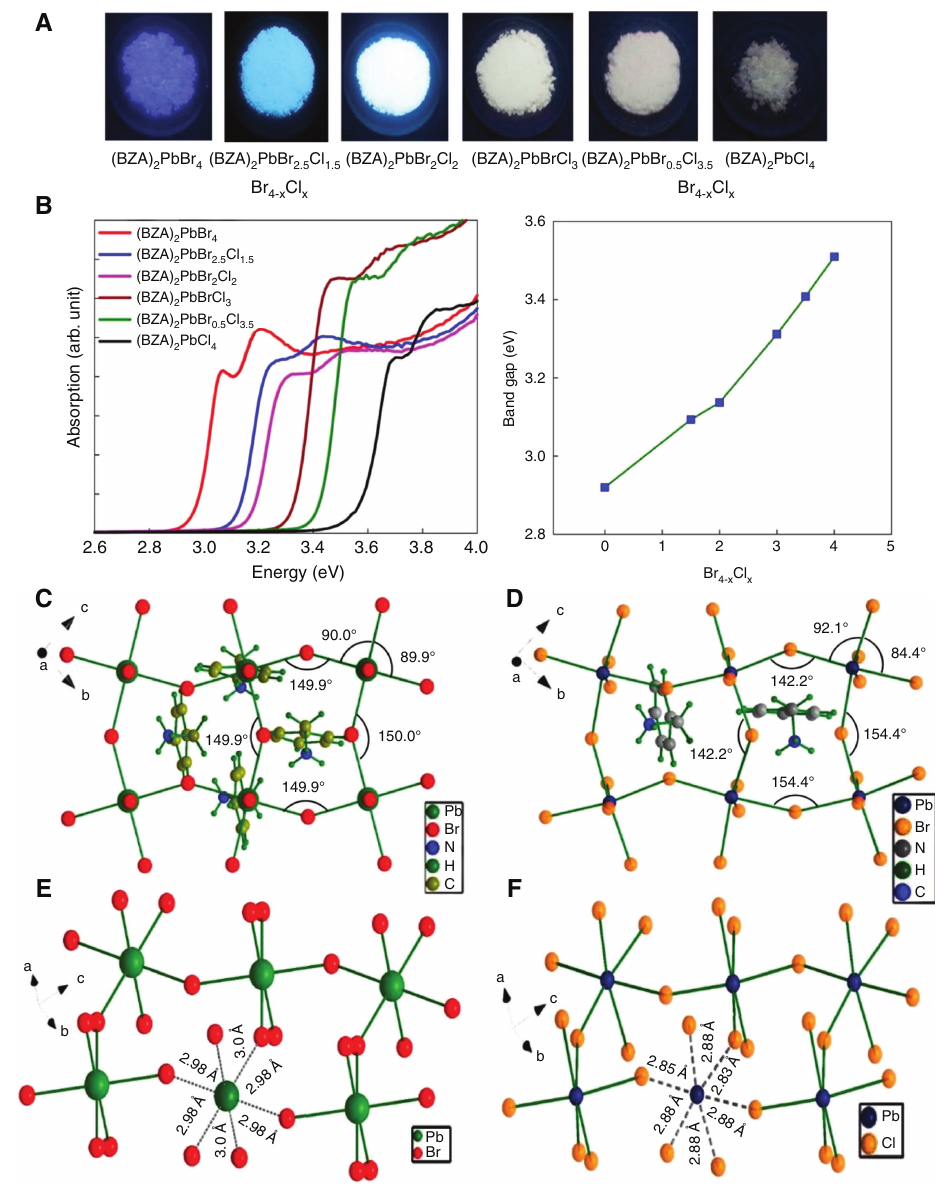
PbBr perovskite. 2 4 PbBr powdered polycrystalline sample and white-light emission from the (BZA) 2 4 = 365 or 254 nm. (B) Diffuse reflectance spectra and band gaps of the solid ex PbBr Cl perovskite ( x = 4, 3.5, 3, 2, 1.5, 0) series. Structural geometry of (C) (BZA) 2 4− x x